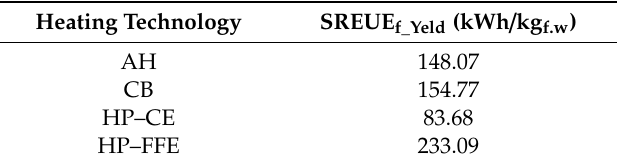
Table 9. Kilowatt-hours expended for kilogram of fresh harvested biomass of the three tested heating technologies. CB: condensing boiler; AH: air heater; HP: heat pump; CE: captured energy; FFE: fossil fuel